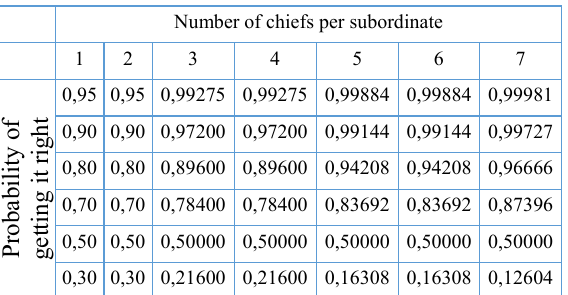
Table 3. Accuracy in decisions made by a collective of n elements that have an individual accuracy of 95%. Number of chiefs per subordinate